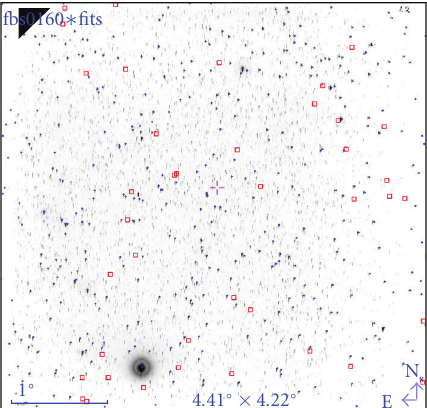
Figure 9: An example of the Byurakan Spectral Plate (FOV = 4 ◦ × 4 ◦ ).